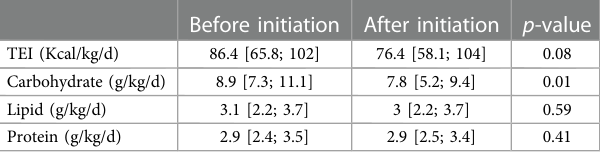
TABLE 2 Changes in macronutrient intakes with lumacaftor/ivacaftor.